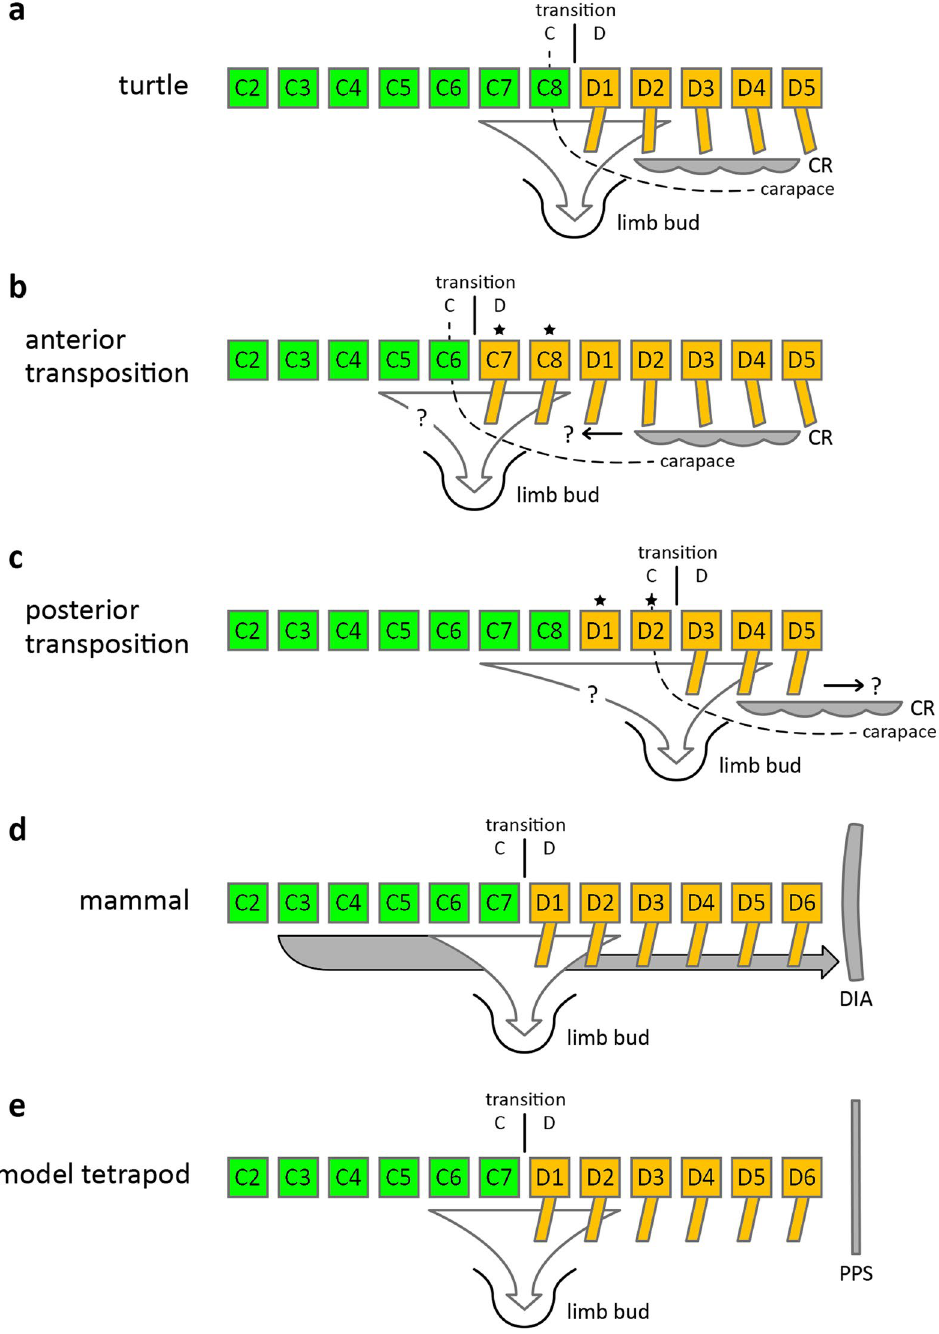
Figure 6. Numeric constraint in the cervical vertebral column in turtles. In general, the forelimb of tetrapods deviates from somitic cells of the cervical and dorsal (thoracic) vertebrae. An anterior or posterior transposition of the forelimb in relation to the axial skeleton can result in change of cervical count. However, this is postulated to be associated with adaptive costs and possibly affecting related anatomical structures (Buchholtz et al . 2012, Buchholtz 2014). ( a ) In turtles, the carapacial ridge (CR) forms posterior to the forelimb. It induces the fan- shape arrangement of the trunk ribs contributing to the development of the carapace. ( b and c ) An anterior or posterior transposition of the forelimb (more and less cervical vertebrae, respectively) may possibly affect the CR. This may generate a deficiency in the development of the turtle carapace. Asterisk indicates modified vertebral morphology. ( d ) In mammals, mid-cervical somitic cells migrate to form the diaphragm (DIA) (mammal based on Buchholtz et al . 2012, Buchholtz 2014). An anterior or posterior transposition of the forelimb are thought to generate a deficient diaphragm, forelimb, or both (Buchholtz et al . 2012, Buchholtz 2014). ( e ) In non-mammals, the post-pulmonary septum (PPS) is unmuscularized and an anterior or posterior transposition of the forelimb is unconstrained (model tetrapod based on Buchholtz et al . 2012, Buchholtz